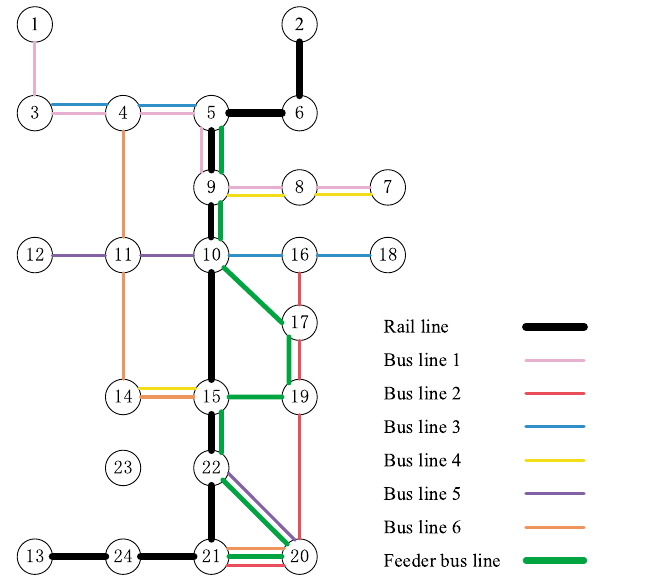
Figure 4. Optimal route configuration of the feeder bus.